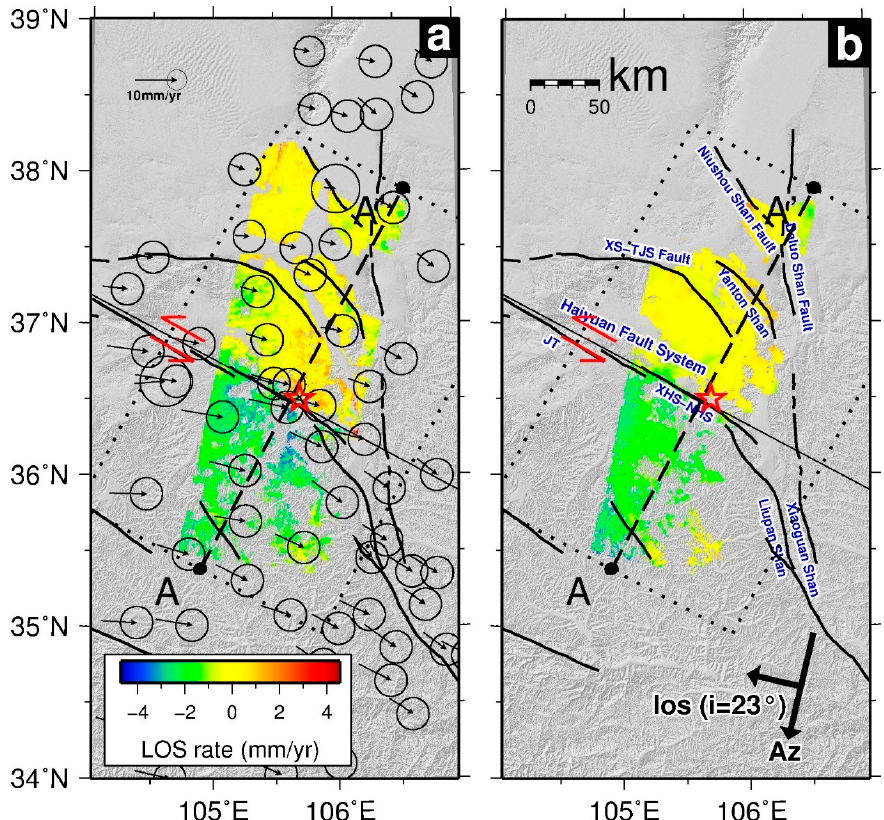
Figure 3. ( a ) Mean line-of-sight (LOS) ratemap for track 18 produced from MERIS-corrected interferograms indicated by red line in Figure S1. A positive LOS displacement corresponds to movement away from the satellite. A-A’ marks the profile shown in Figure 4a. GPS data with respect to the Eurasia-fixed Reference Frame is from Gan et al. [22]. ( b ) Mean LOS ratemap for track 18 produced from ECMWF-corrected interferograms indicated by green line in Figure S1. The perpendicular pair of arrows shows the direction in which the satellite moves (Az), the satellite line-of-sight direction (los), and the incidence angle (i) at the centre of the scene. JT: Jing Tai fault, XHS-NHS: Xihua Shan-Nanhua Shan fault, XS-TJS: Xiang Shan-Tianjing